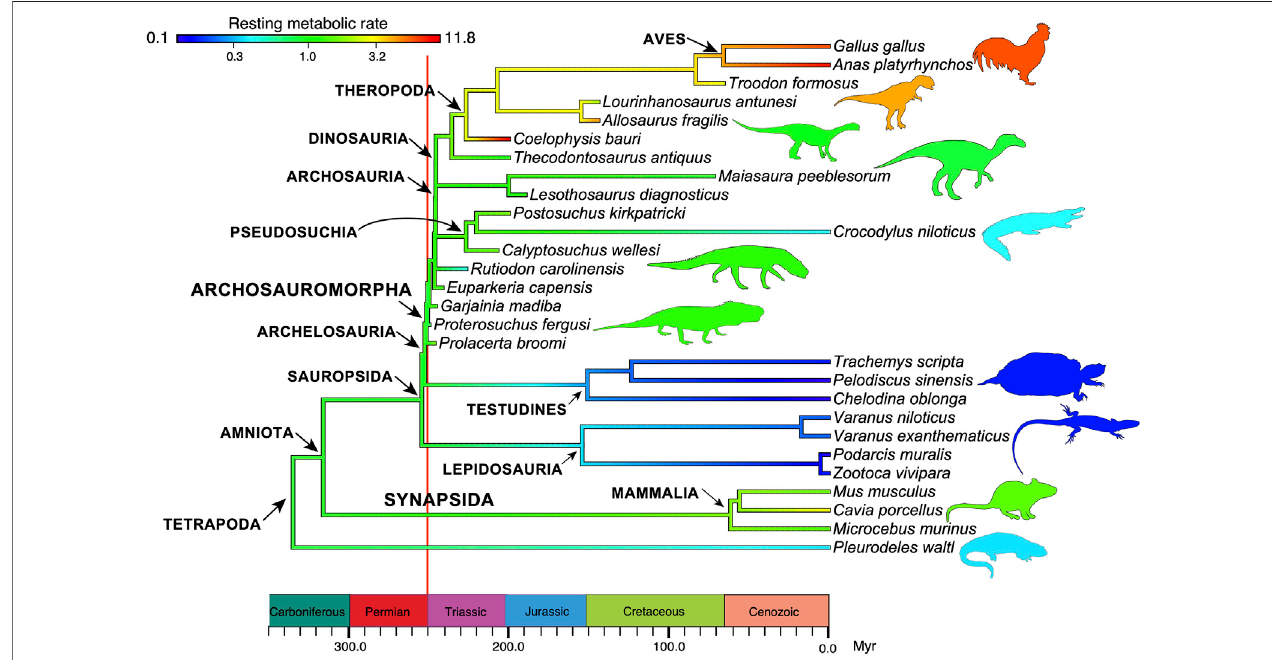
FIGURE 7 | The evolution of endothermy in archosauromorphs and synapsids from the Permian to the present day. In the analysis, ancestral states of resting metabolic rates, measured in mLO 2 h − 1 g − 0.67 , are estimated at each branching point in the phylogeny and color-coded to indicate the level (note the logarithmic scale). Values for ectotherms are typically 1.0, with modern mammals having RMR values in the range 1.5 – 3.5, and modern birds, 8 – 12 mLO 2 h − 1 g − 0.67 . Based on data in Legendre et al. (2016), with thanks to Lucas Legendre for the base image.